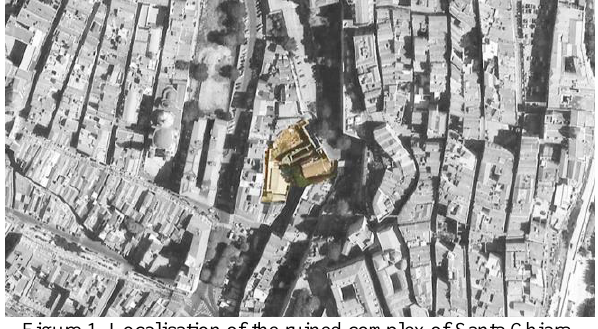
Figure 1. Localisation of the ruined complex of Santa Chiara (Pilia E.).